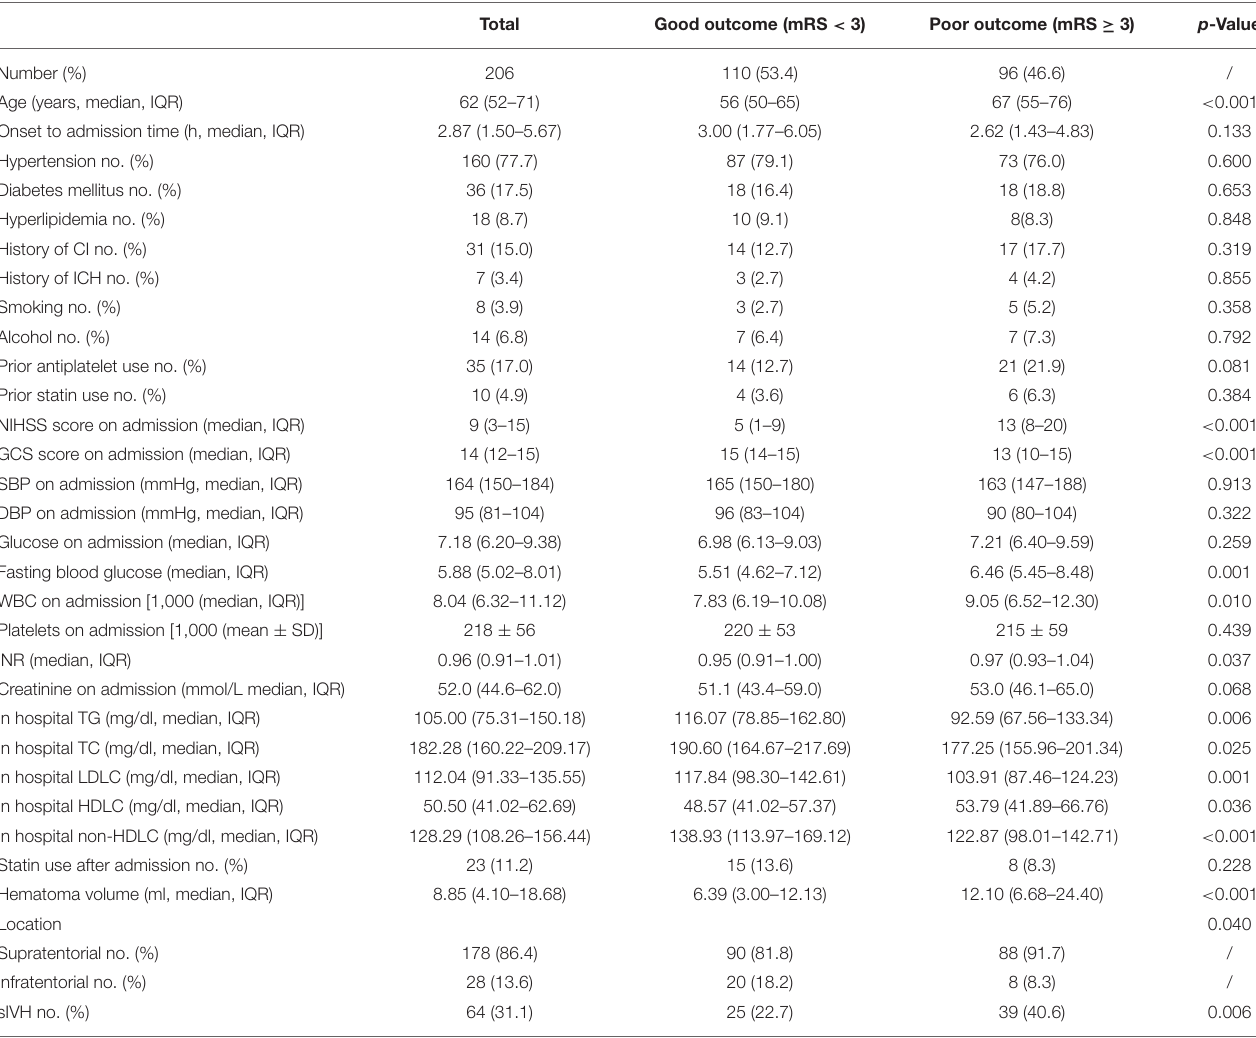
TABLE 1 | Comparison of characteristics between female patients with good and poor 3-month clinical outcome. Total Good outcome (mRS < 3) Poor outcome (mRS ≥ 3) p